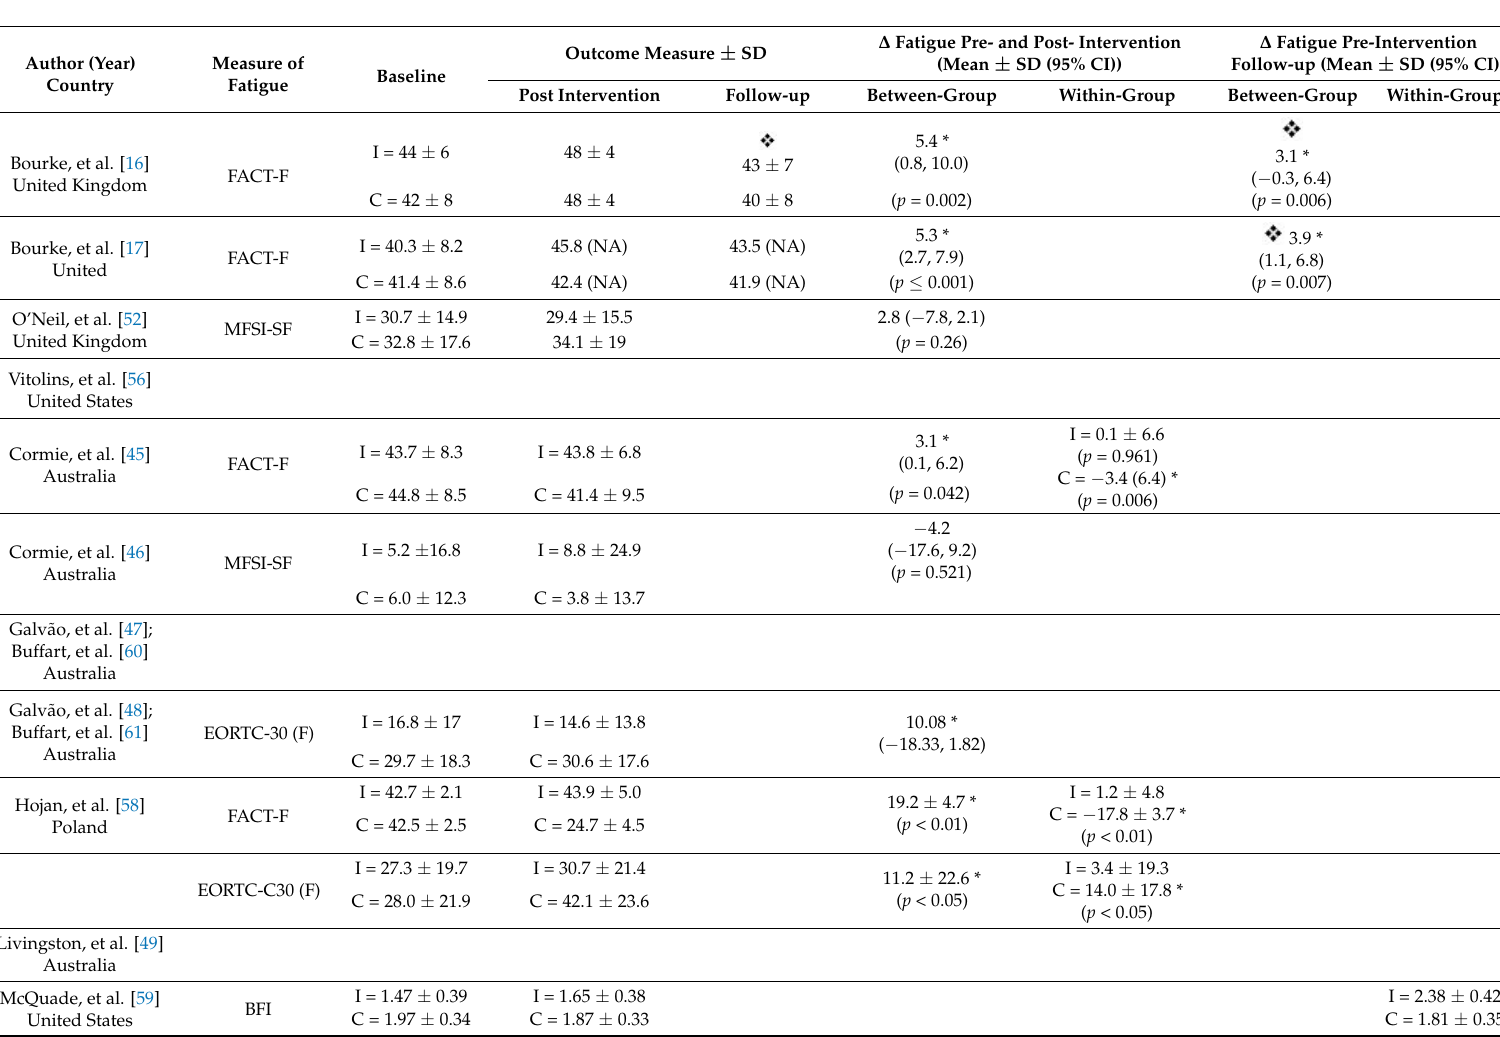
Table 4. Cancer-related fatigue outcome